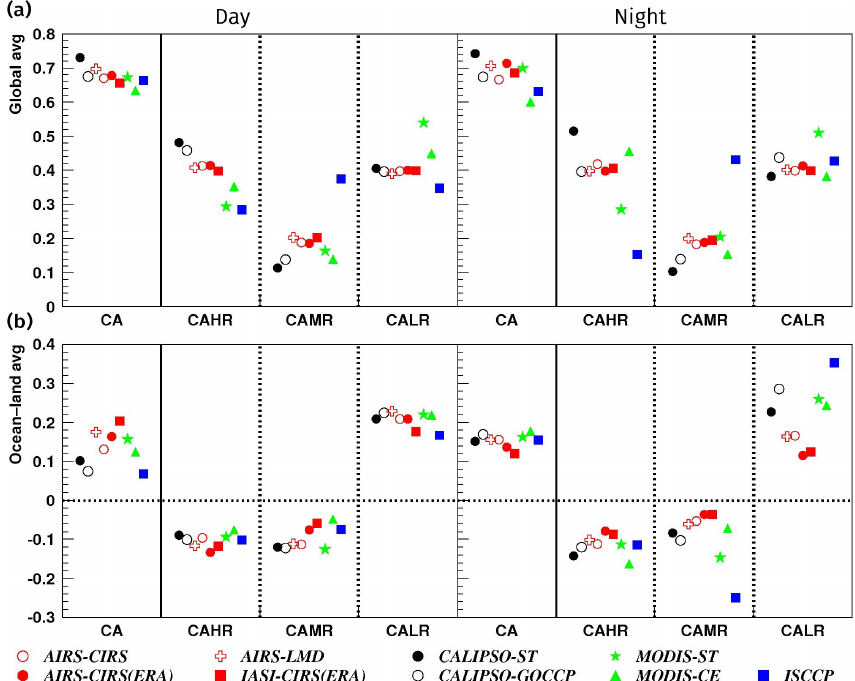
Figure 7. (a) Global averages of total cloud amount (CA) and fraction of high-level, mid-level and low-level cloud amount, relative to total cloud amount (CAHR + CAMR + CALR = 1). Comparisons of IR sounder cloud data (AIRS, IASI) with L3 data from the GEWEX Cloud Assessment database, separately for observations mostly during day (13:30LT; 15:00LT for ISCCP and 09:30LT for IASI, left) and mostly during night (01:30LT; 03:00LT for ISCCP and 21:30LT for IASI). Compared to the original ISCCP data, the day–night adjustment on CA has not been included to better illustrate the differences between VIS–IR and IR-only results. (b) Averages of ocean–land differences for the same parameters and data sets.